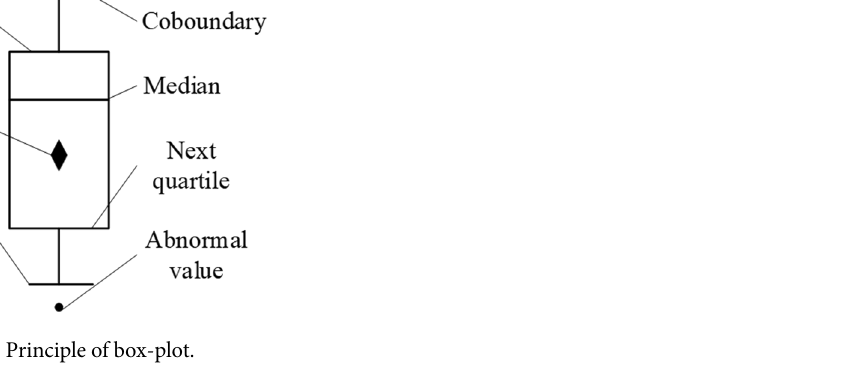
Figure 8. Principle of